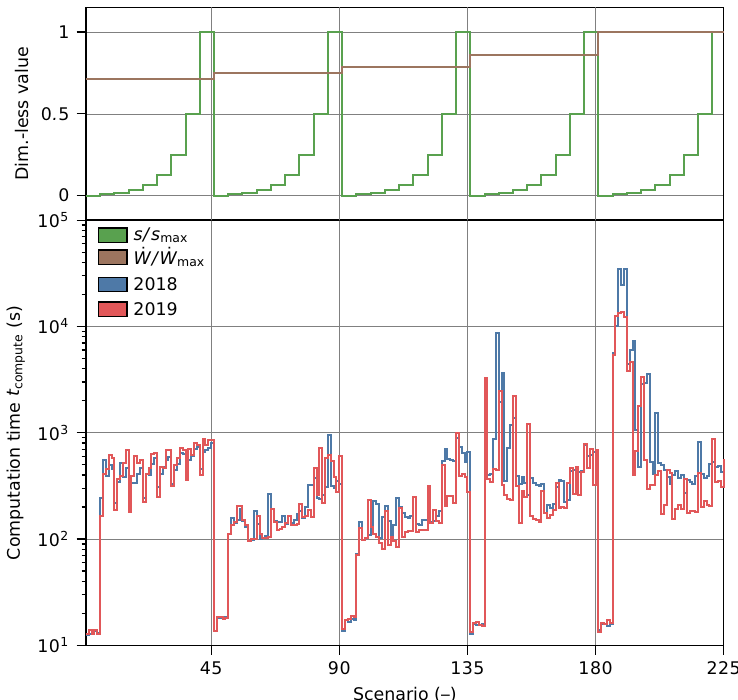
Figure 5. Computation time over increasing total power ˙ W total , storage volume s and bid factor b ref